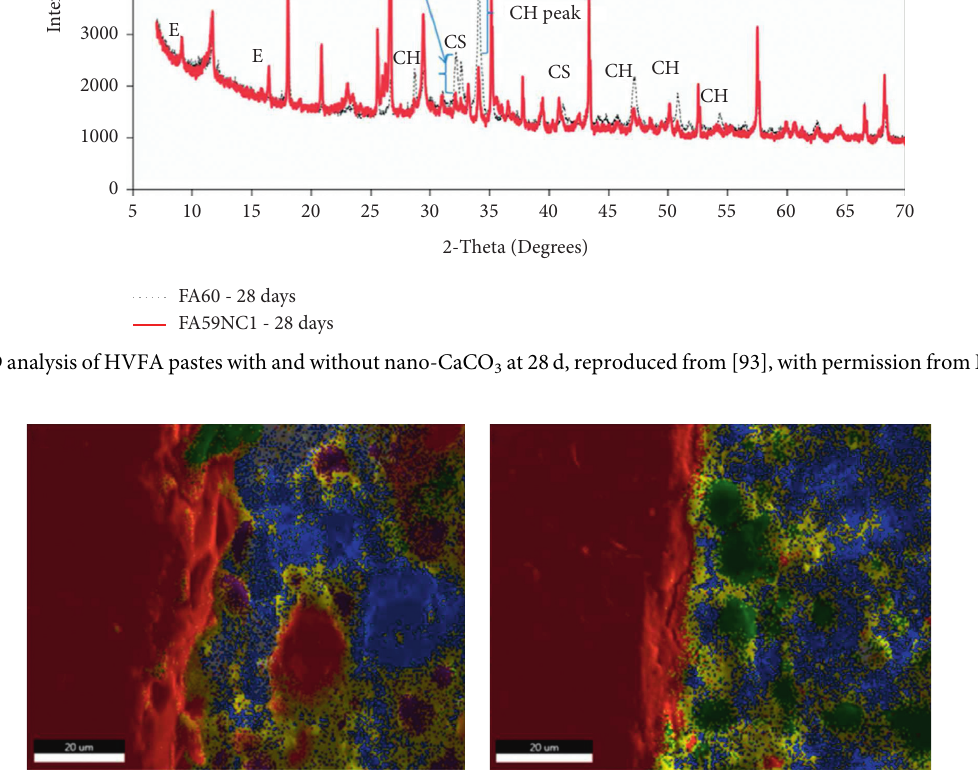
Figure 20: SEM-EDS analysis of the ITZ in HVFA concrete: (a) no addition of nanosilica; (b) admixing 1 wt% nanosilica (Red part, Si-rich phase such as aggregate; blue and yellow parts, Ca-rich phase such as CH; green part, C-S-H), reproduced from [38], with permission from Elsevier, 2021. SEM, scanning electron microscopy; EDS, energy-dispersive X-ray spectroscopy.